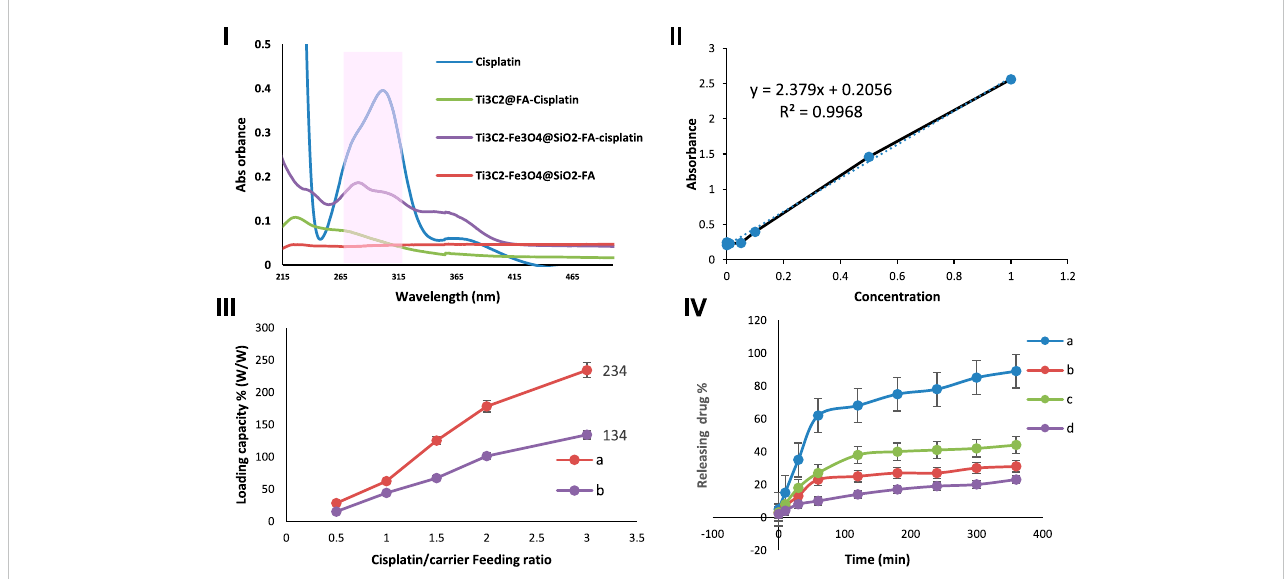
FIGURE 8 I) UV-Vis absorbance of Cisplatin, Ti 3 C 2 -Fe 3 O 4 @SiO 2 -FA, Ti 3 C 2 -Fe 3 O 4 @SiO 2 -FA-Cisplatin, and Ti 3 C 2 @ FA-Cisplatin. II) Standard calibration curve for different concentrations of Cisplatin (2.5, 5, 10, 20, 50, 100) irradiation at 293 nm, III) Cisplatin release pro fi le of Ti 3 C 2 -Fe 3 O 4 @SiO 2 -FA and Ti 3 C 2 @FA at different drug/nanocarrier ratios (0.5, 1, 1.5, 2, 3) irradiation at 293 nm, and IV) The Cisplatin release from Ti 3 C 2 -Fe 3 O 4 @SiO 2 -FA-Cisplatin (A, C) and Ti 3 C 2 @- FA-Cisplatin (B, D) in PBS (0.1 M) solution at two pH 4.5, and 7.4, respectively (n = 3).